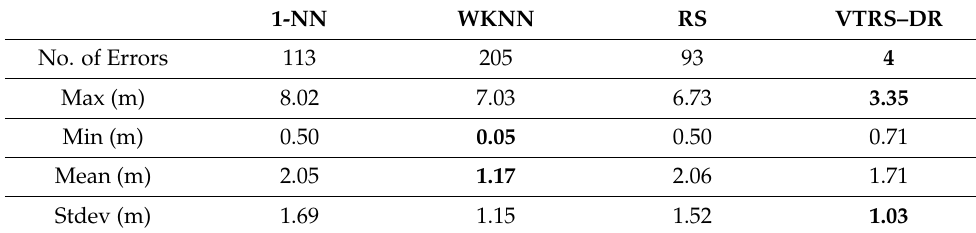
Figure 4. The positioning error distance of four methods via 205 RPs in Case 1. Table 6. Statistical comparison of four methods in Case 1 at error positions.